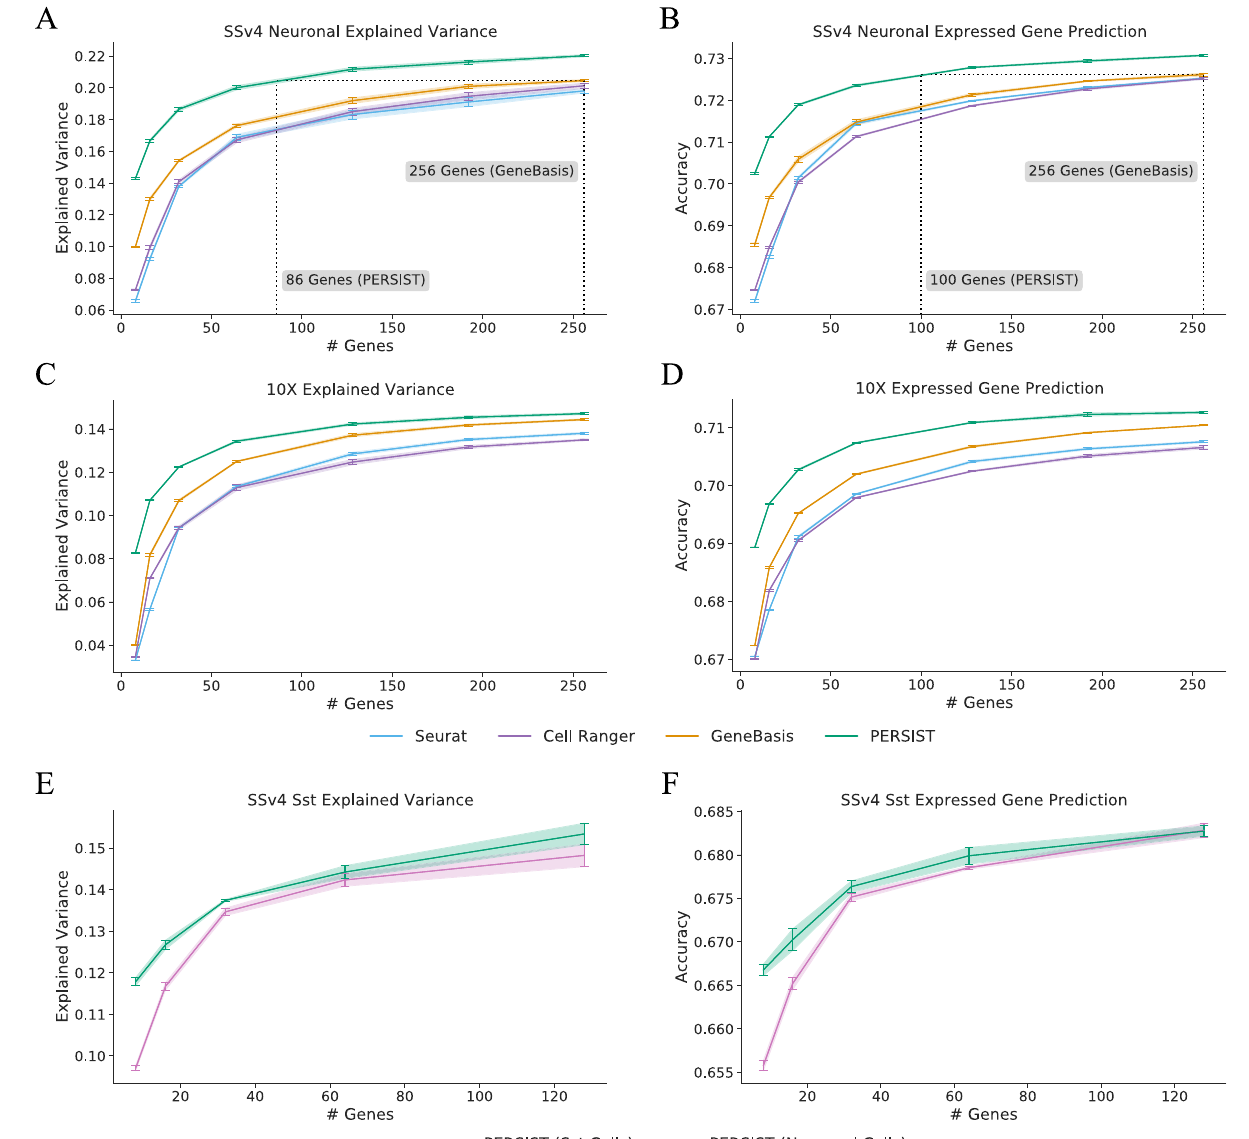
Fig. 2 | Evaluating gene panels based on their abilityto reconstruct scRNA-seq expressionpro fi les. Theselectedgenesareusedtopredicteitherlog-normalized expression counts for the remaining genes ( A , C , E ) or whether each gene is expressed in the genome-wide pro fi le ( B , D , F ). The panels selected by PERSIST perform better than those selected by previous methods. A Explained variance for gene panels identi fi ed by PERSIST and other methods with the SSv4 V1/ALM neuronal cells (higher is better). B Expressed gene prediction accuracy with the SSv4 V1/ALM neuronal cells (higher is better). C Explained variance for gene